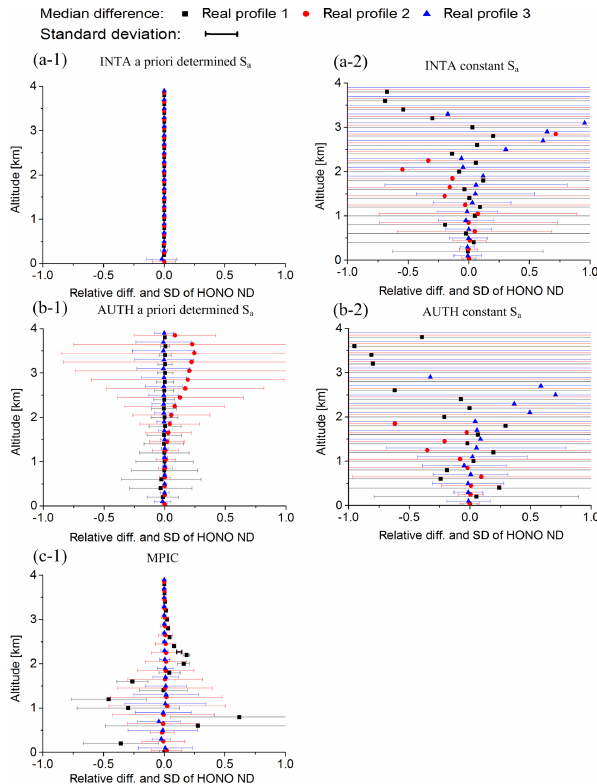
Figure 11. Median and standard deviations of the relative differ- ences of the HONO VMR profiles retrieved from the simulated HONO delta SCDs with added artificial noise compared to those without noise by the different participants using a different inver- sion algorithm with “constant Sa” and “a priori determined Sa” (see